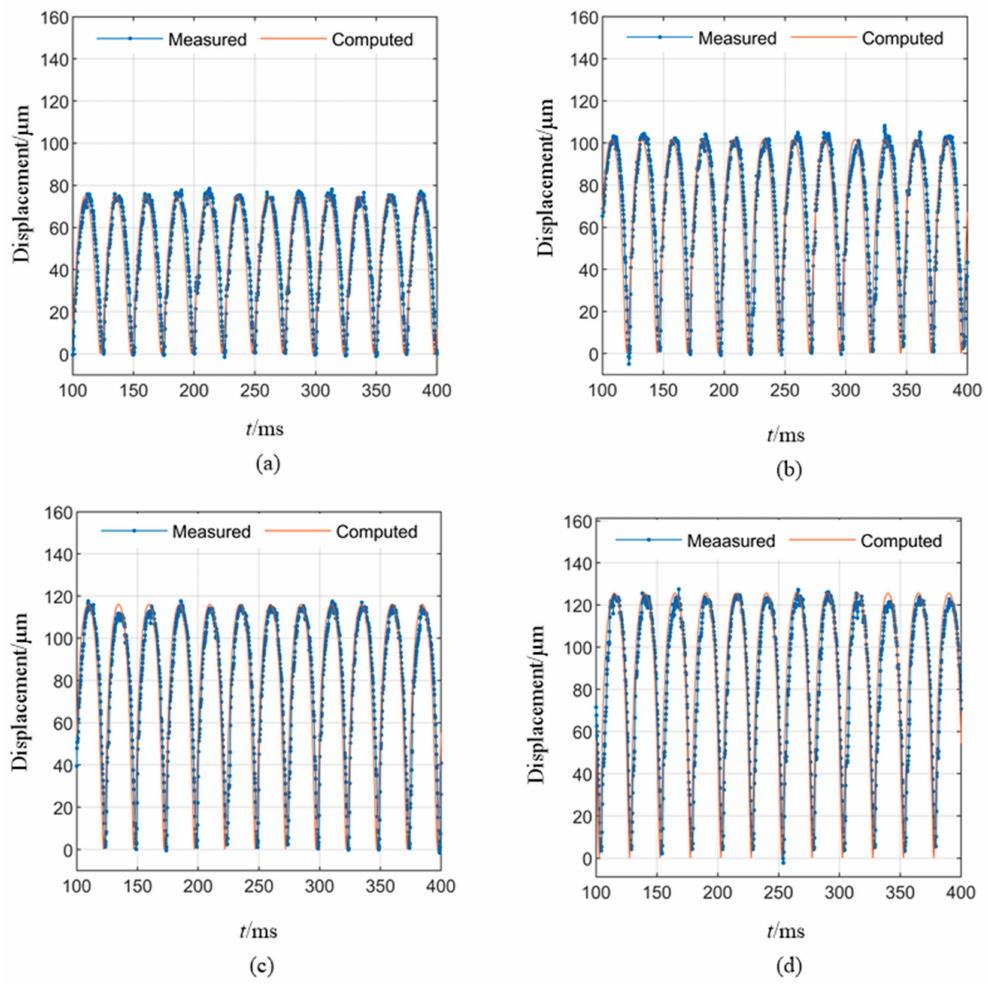
Figure 9. Input sinusoidal alternating current GMA displacement output: ( a ) I = 2 A; ( b ) I = 3 A; ( c ) I = 4 A; ( d ) I = 5